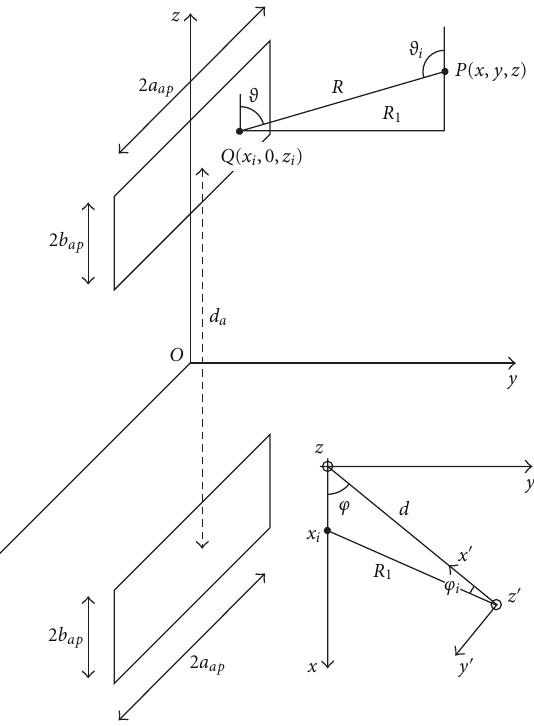
Figure 2: Relevant to the geometry of the